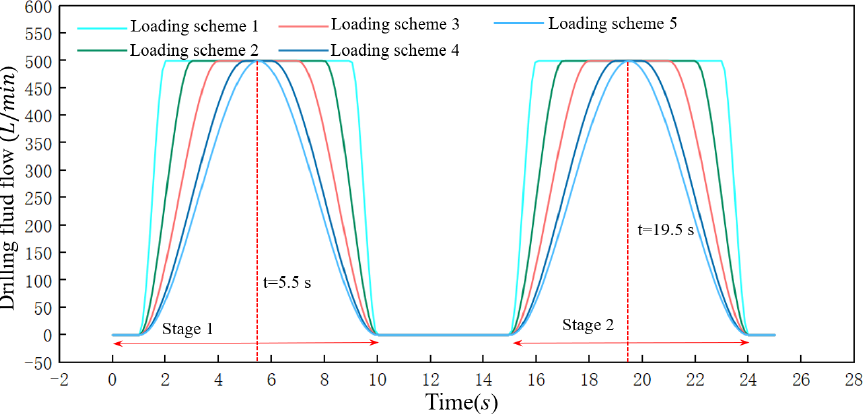
Figure 9. Five different flow loading schemes.